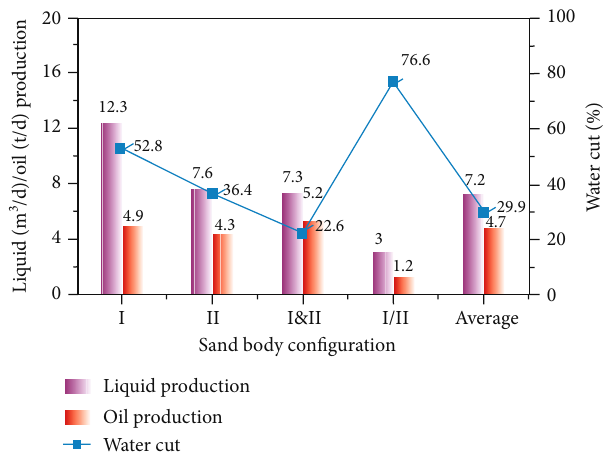
Figure 15: Comparison of initial production of di ff erent sand body con fi gurations.